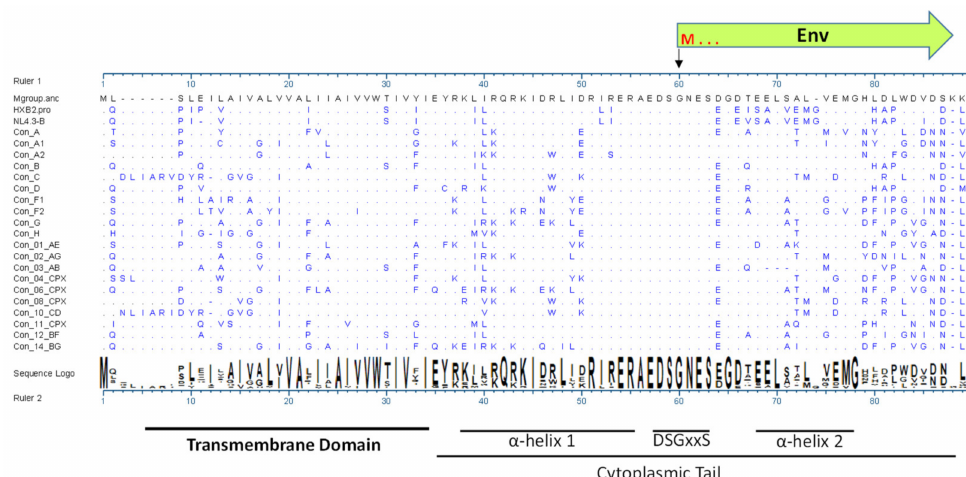
Figure 1. Alignment of consensus sequence of Vpu from HIV-1 group M subtypes showing amino acid variability especially in the C-terminus. Source: Los Alamos HIV Database at https://www.hiv. lanl.gov/content/sequence/HIV/mainpage.html (accessed on 1 January 2022). The first amino acid in Env open reading frame methionine is denoted by